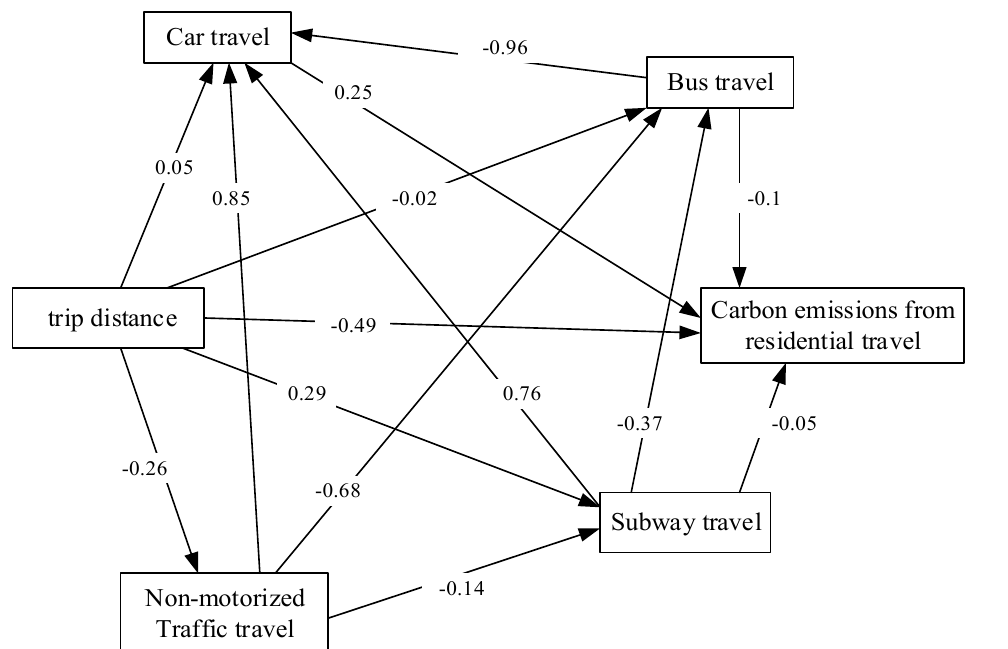
Figure 7. Endogenous variable effect path. Note: 1. the path coefficient is 0.1, which means 1 standard deviation of the independent variable affects 0.1 standard deviations of the dependent variable. 2. A → B → C means that A affects C through affecting B, and the indirect effect is the product of the coefficients of each path.